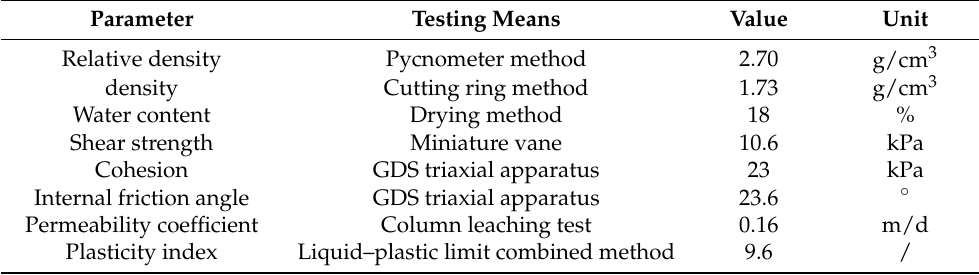
Table 2. Physical and mechanical parameters of test soil samples.